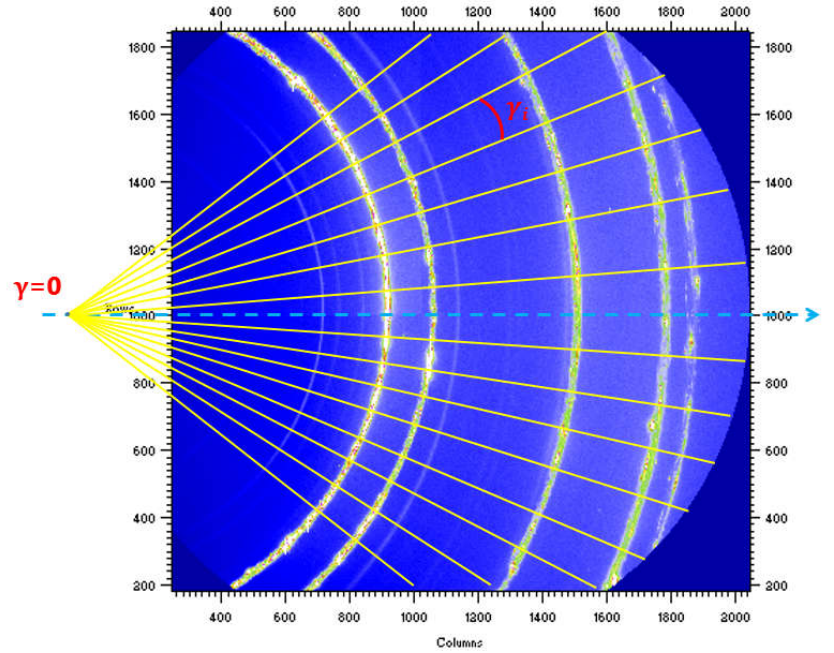
Figure 6. Subdivision of the rings for the Ni30Cr/Cr 2 O 3 system.